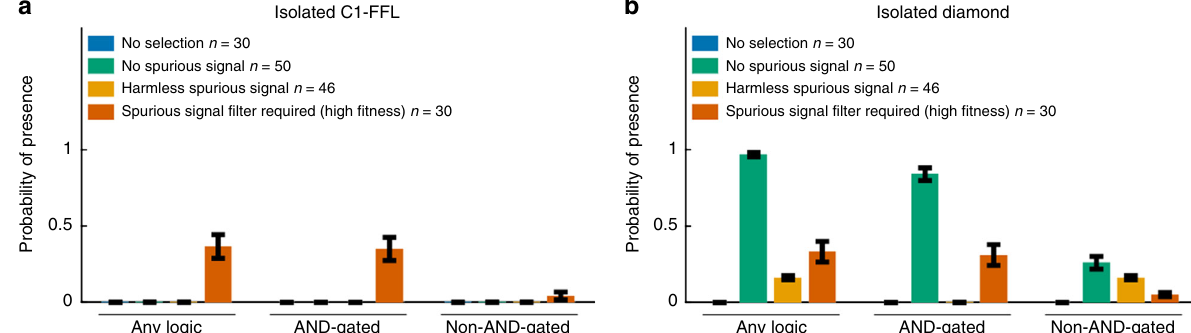
Fig. 10 AND-gated diamonds, but not AND-gated C1-FFLs, also evolve in negative controls. a Selection for fi ltering out a short spurious signal is the primary way to evolve AND-gated isolated C1-FFLs, but b AND-gated isolated diamonds also evolve in the absence of spurious signals. The selection conditions are the same as in Fig. 6, but we do not allow the signal to directly regulate the effector. In the “ no spurious signal ” and “ harmless spurious signal ” control conditions, motif frequencies are similar between low- and high- fi tness genotypes (Supplementary Figs. 8 and 9), and so our analysis includes all evolutionary replicates. When scoring motifs, we exclude all two-mismatch TFBSs; results with inclusions, and for FFL-in-diamonds, are shown in Supplementary Fig. 10. Many non-AND-gated diamonds have the “ no regulation ” logic in Fig. 2, perhaps as an artifact created by the duplication and divergence of intermediate TFs; we excluded them from the “ Any logic ” and “ Non-AND-gated ” tallies in ( b ). See Supplementary Methods for the calculation of the y -axis. Data are shown as mean ± s.e.m. over evolutionary replicates. We reused data from Fig. 7 for “ Spurious signal fi lter required (high fi tness)